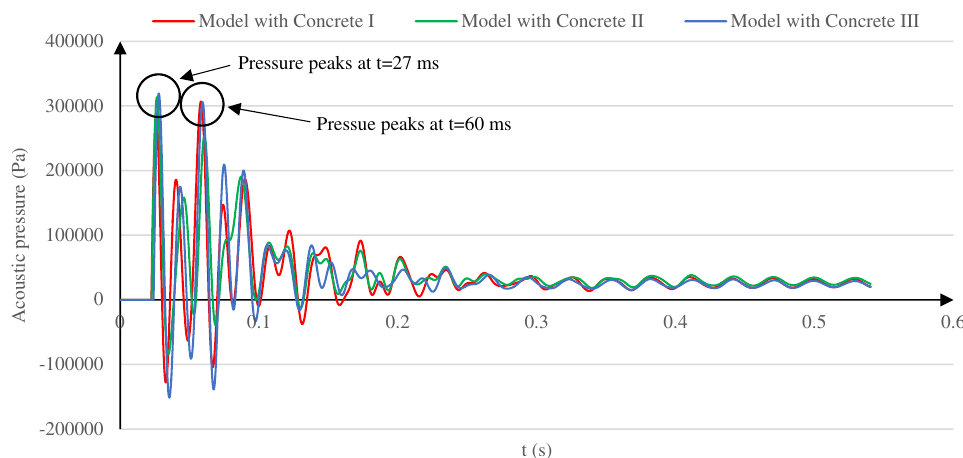
Figure 9. Pressure time histories of the reflected acoustic wave for the models with Concrete I, Concrete II, and Concrete III as the tunnel lining